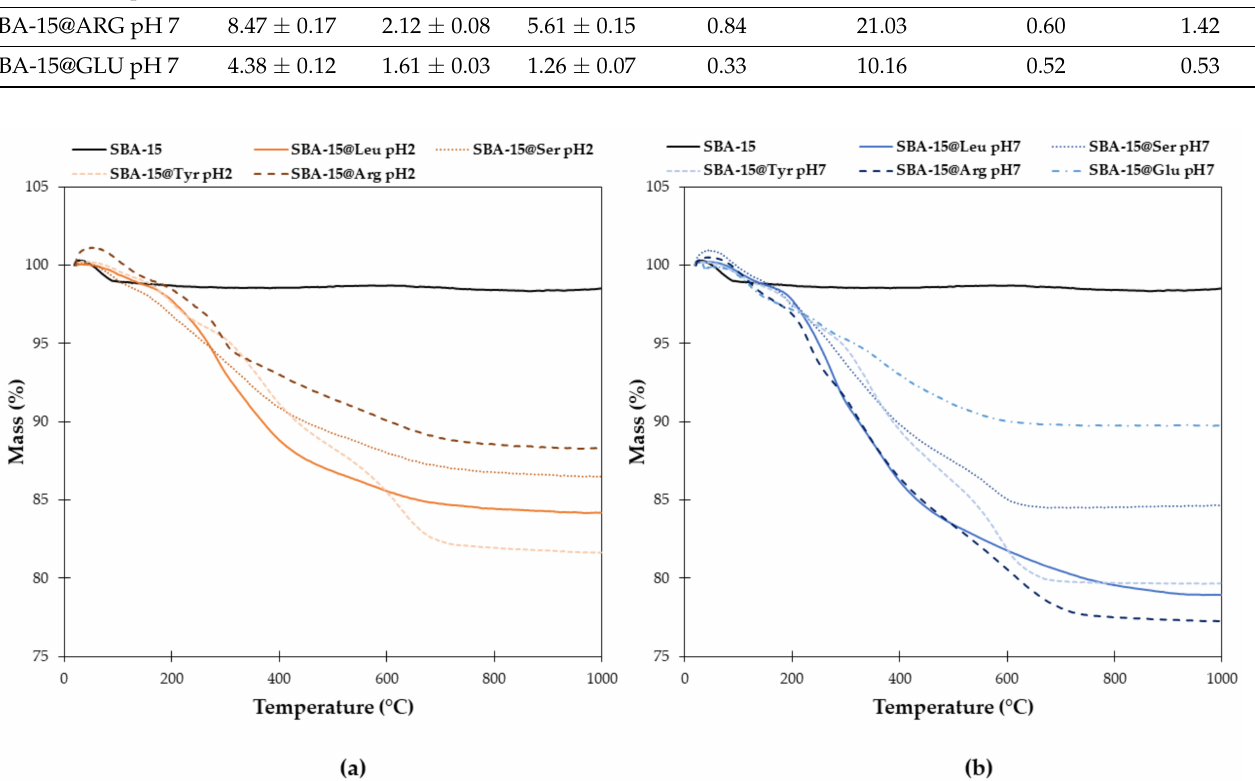
Figure 10. TGA curves of SBA-15 (black) and the SBA-15@AA at pH 2 ( a ) and pH 7 ( b ). The density of AA grafting onto SBA was expressed as number of molecules of Si-AA- NH 2 per nm 2 (Table 3). For example, a density of 1.16 Si-Tyr-NH 2 per nm 2 was calculated for SBA-15@Tyr pH 2 from the 18.36 mass loss. Except for Si-Glu-NH 2 , all the Si-AA-NH 2 functionalized with a nucleophilic catalyst (SBA-15@AA pH 7) displayed a density ranging from 1 to 1.42 Si-AA-NH 2 per nm 2 , which confirmed the creation of a monolayer of AA. This observation is in agreement with the values of hybrid layer thickness obtained from N 2 adsorption